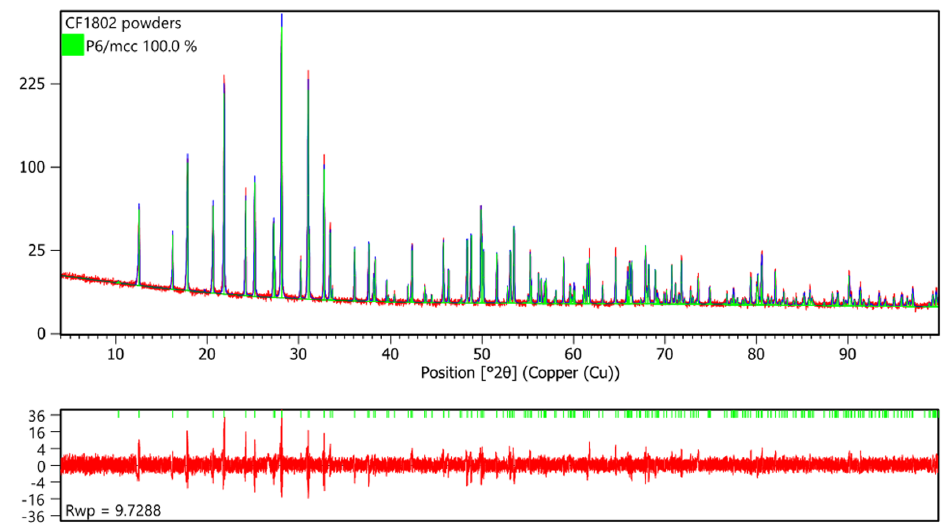
Figure 5. Rietveld refinement of the X-ray powder diffraction pattern of laurentthomasite.